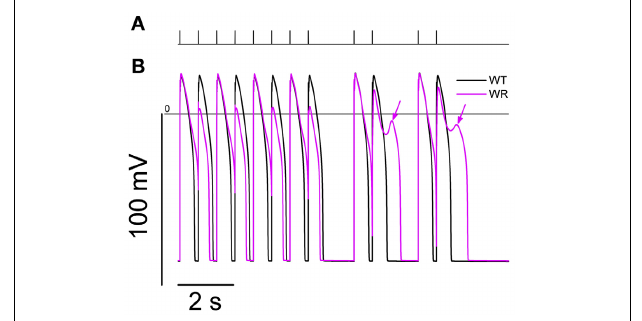
FIGURE 9 | Simulation of an interval variations paradigm known to trigger EADs and Torsades de Pointes . From SS at 0.5Hz, a series of 40 stimulations were applied at 666ms intervals. Then, a combination of a 1666ms interval plus a couple of stimulations at 666ms interval was applied twice (panel A ). The action potentials produced by model for the last 12s of the protocol are shown in (B) . While the WT model (black line) shows a separate AP in response to each stimulation, the WR model APD 90 (magenta line) was longer than the 666ms interval, causing a bigeminal aspect: every second AP is smaller and shorter. After the pauses, EADs were present in the WR model only